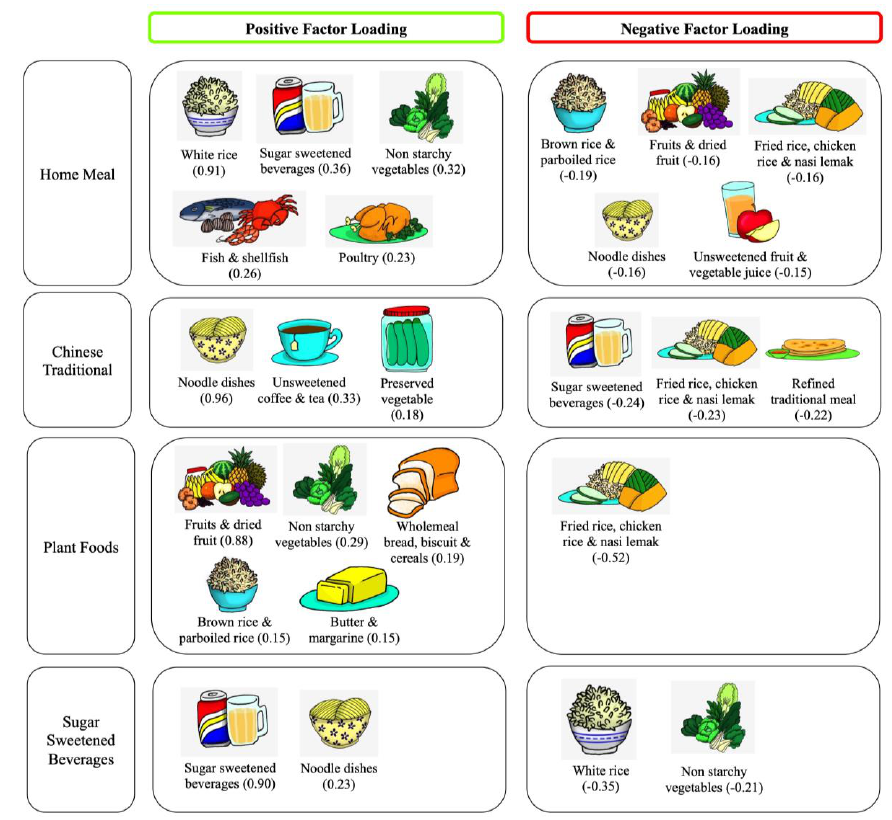
Figure 1. Factor loadings for four dietary patterns in the MLS population ( n = 562). Dietary pattern extraction is by principal component analysis; numbers in parenthesis indicate factor loading for that food